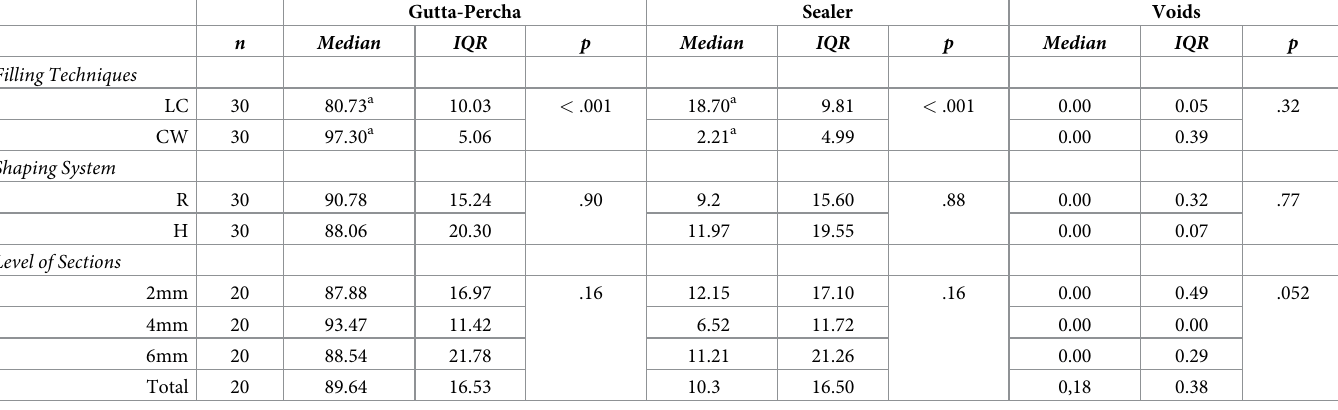
Table 5. Mann-Whitney U and Kruskal-Wallis tests results with descriptive statistics of C2-type’s median percentage values of gutta-percha, sealer and voids according to filling techniques, shaping system and level of sections.